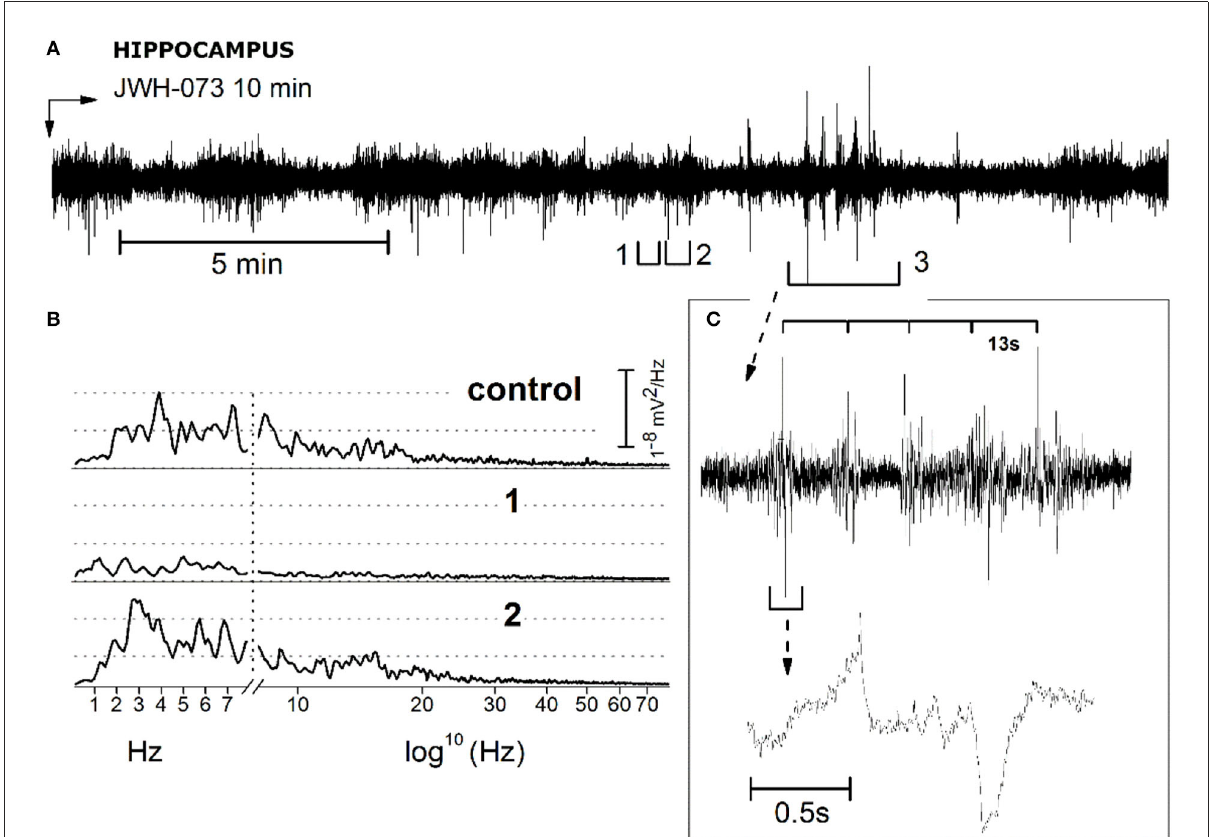
FIGURE11 Description and analysis of unusual electrical EEG hippocampal activity resulting from JWH-073 administration. (A) Representative EEG recording. Segments tagged as 1 and 2, points to characteristic short traits frequently present only after JWH-073 administration. Panel (B) compares the FFT of control (recorded soon before JWH-073), complex 1, complex 2. Similar to Figure 9, X axis has been broken: linear between 0.05 and 8Hz, logarithmic from 8.01 to 150Hz. (C) Analysis of segment 3. Top: segment “3” at a faster time scale. Time scale bar above the trace identifies a spiking rhythmicity (13s). Bottom: one of these upper events, shown at a faster